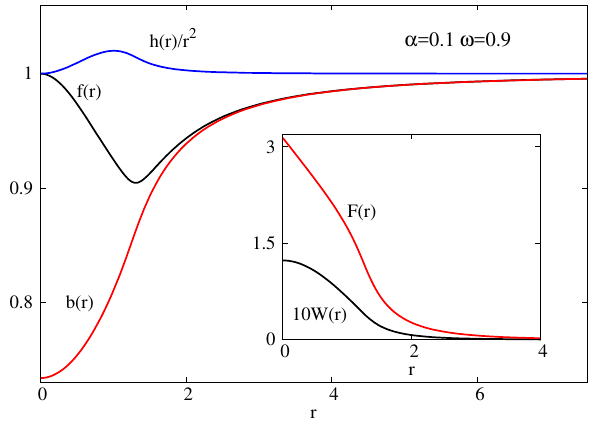
Figure 4 . The pro(cid:12)le functions of a typical spinning Skyrme